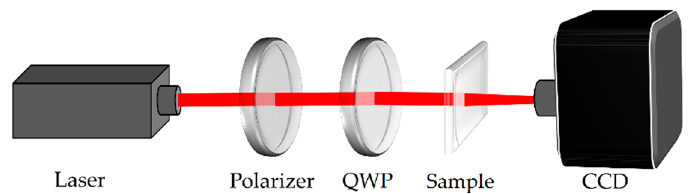
Figure 3. The optical setup for characterizing the performance of the PB lens.